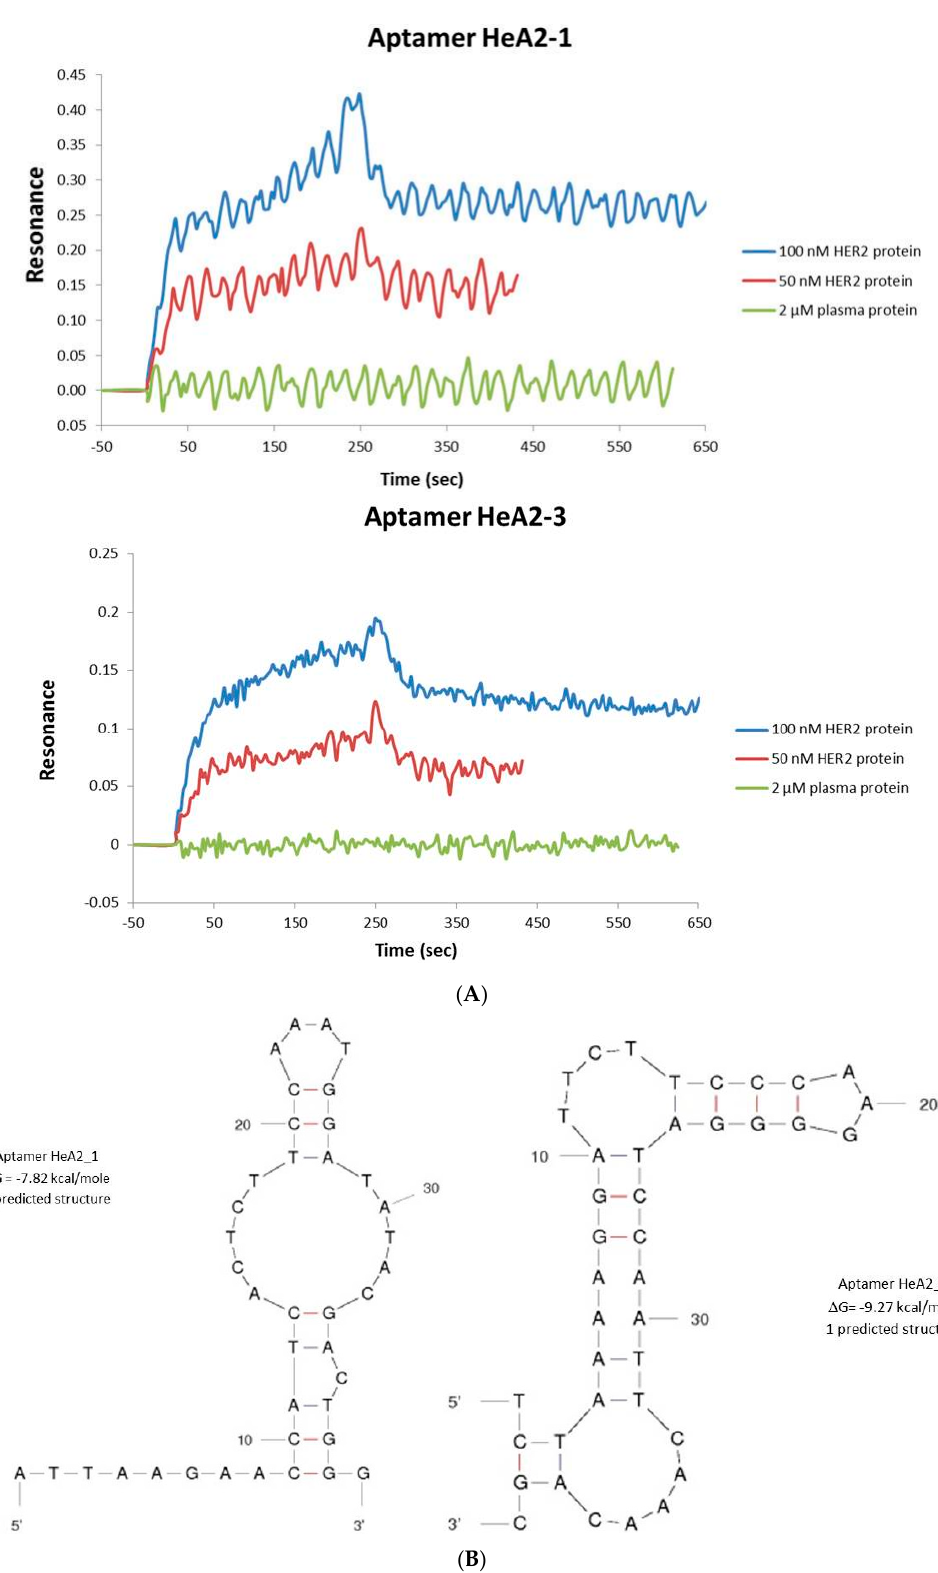
Figure 2. (A) Protein binding assays by SPRi. Sensorgrams for aptamer HeA2_1 ( top ) and HeA2_3 ( bottom ). Injection of the protein started at 0 s and ended at 210 s. Data (mean reflexivity units) are representative for 3 biological replicates. The dissociation (Koff) coefficient was calculated as described in the experimental section; (B) Predicted aptamer secondary structures. The secondary structure was investigated at conditions on selections (37 °C, 120 mM Na, 5 mM Mg). The secondary structure and Gibbs free energy ( Δ G, kcal/mole) were predicted using the Mfold software [49,50].